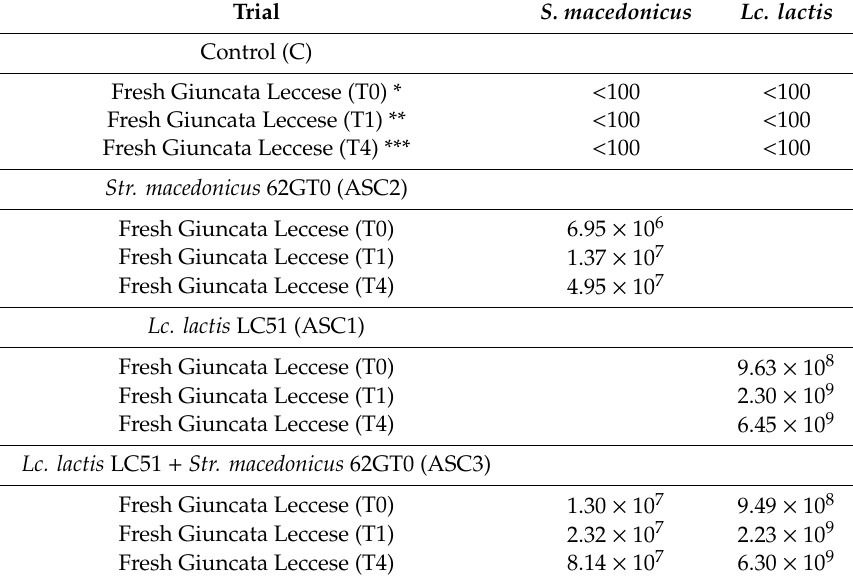
Table 3. Counts (CFU / g) of Lc. lactis LC51 and S. macedonicus 62GT0 from mini-productions of Giuncata Leccese cheeses at a laboratory